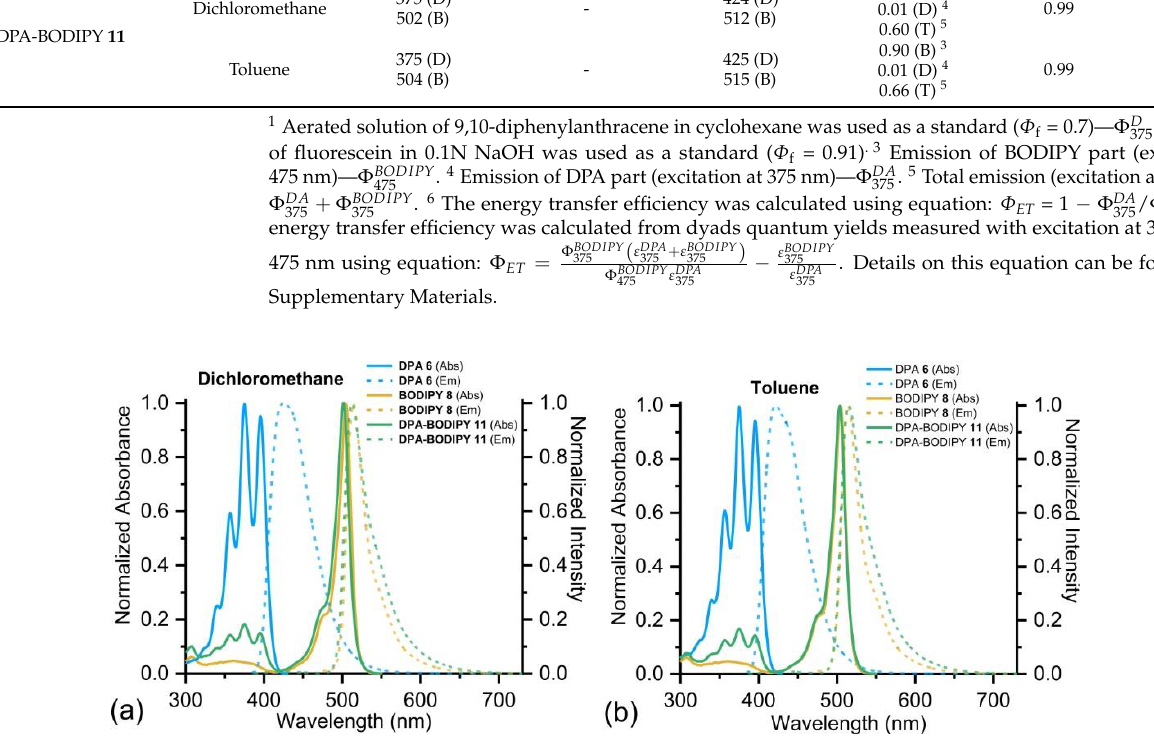
Figure 3. Normalized UV-visible absorption and emission spectra of DPA-COOMe 11 , BODIPY- COOMe 8 and BODIPY-DPA 6 in dichloromethane ( a ) and toluene ( b ) at room temperature. Exci- tation at 375 nm for DPA-COOMe 6 , BODIPY-DPA 11 and at 475 nm for BODIPY-COOMe 8 . Table 1. Photophysical properties of the synthesized